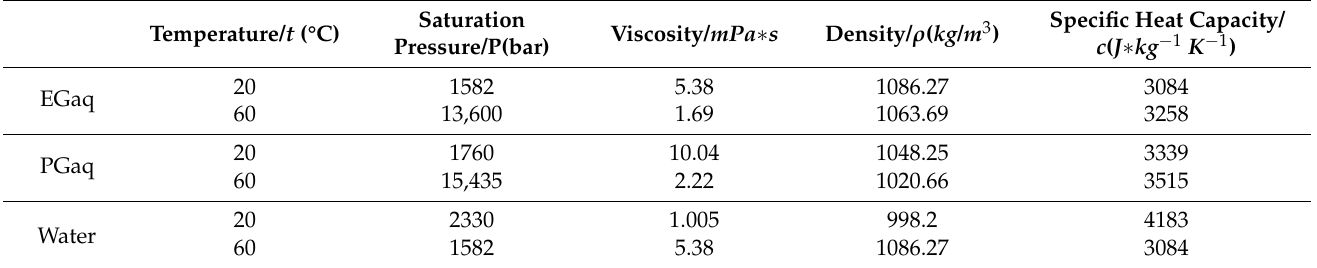
Table 3. Material properties of three cooling medium at different